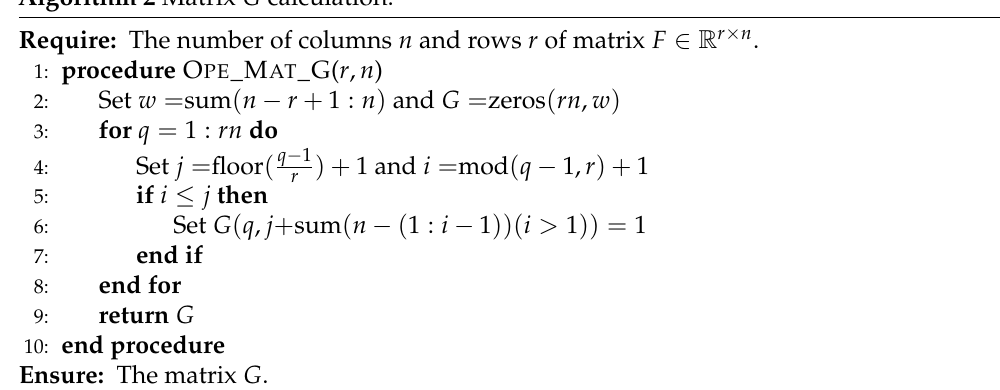
Algorithm 2 Matrix G